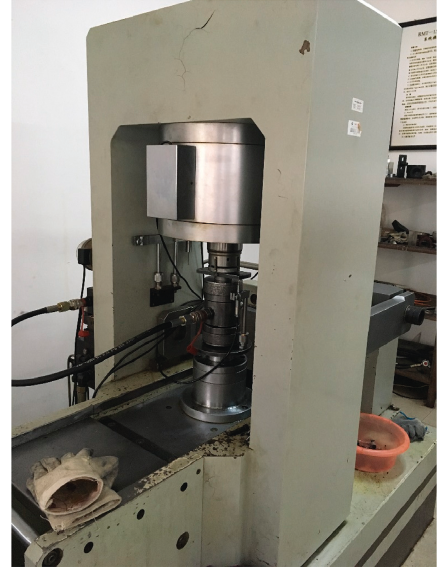
Figure 4: Triaxial compressive testing apparatus. Table 2: Stress state for the triaxial compression and unloading